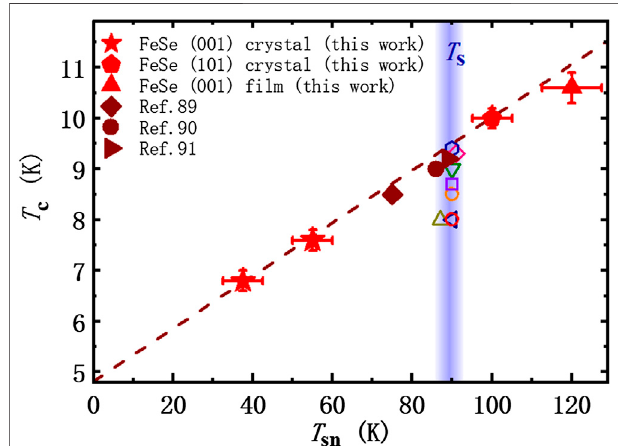
FIGURE 8 | The universal linear relationship between the superconducting transition temperature ( T c ) and the fi eld-induced spin- nematic ordering temperature ( T sn ) among various FeSe samples (the solid symbols) [64]. The hollow symbols in the vertical blue-shaded area represent the structure phase transition temperatures by the x-ray or neutron diffractions on various FeSe samples of different Tc ’ s [30, 52, 55, 86, 92 – 94].